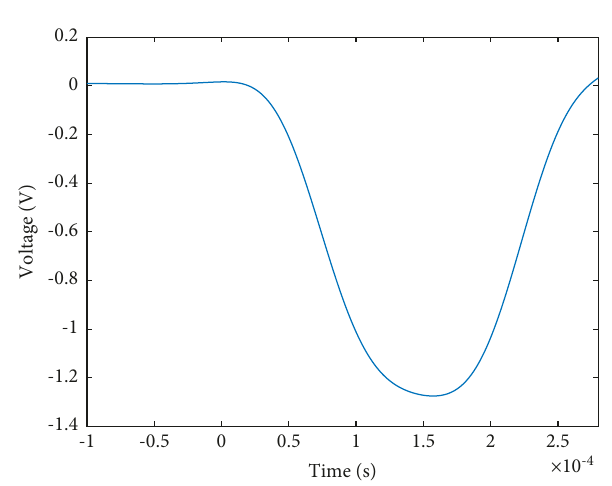
Figure 6: The incident wave after shaping.